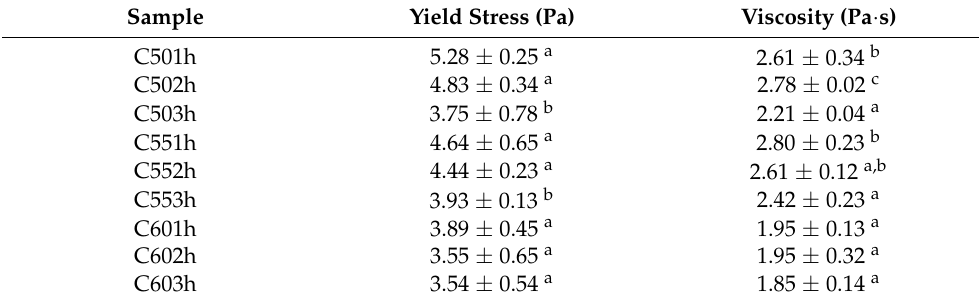
Table 3. Rheological properties of CMM conched under different times and temperatures (the same letter means that there are no statistically significant differences between the analyzed products at a confidence level of α = 0.05; the abbreviations used in the graph are described in Section 3.2).